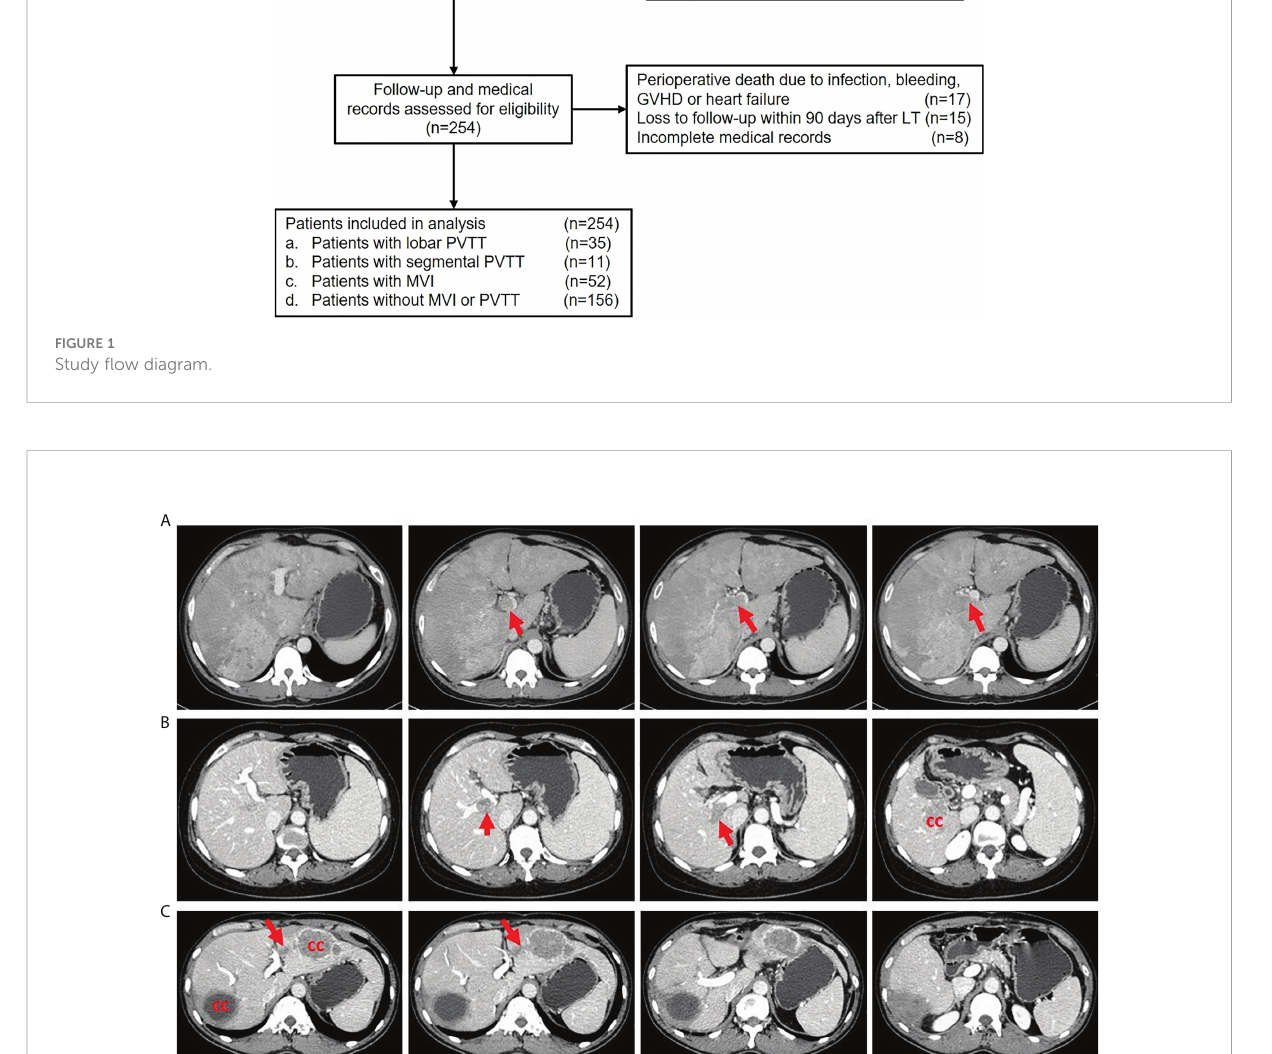
FIGURE 2 Tumor thrombus in different portal vein location. (A) A patient with tumor thrombus in the main trunk of portal vein. (B) A patient with tumor thrombus in the right portal vein. (C) A patient with tumor thrombus in the second branch of portal vein. CC, cancer center.